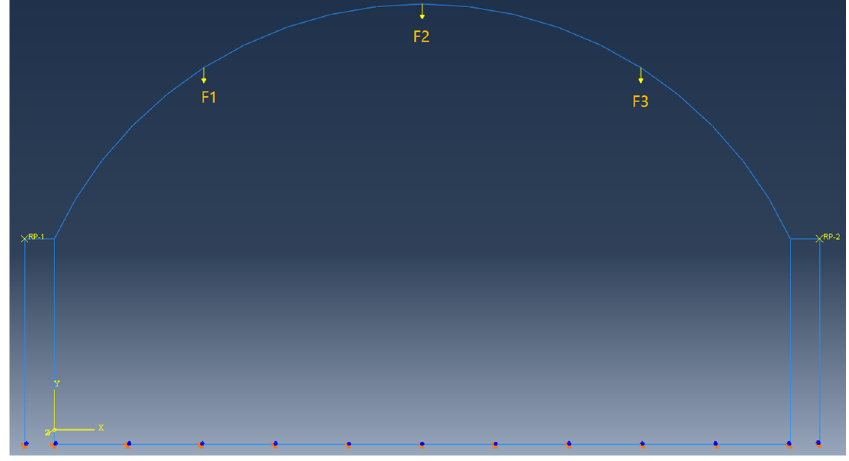
Figure 8. Strain measuring point. F1 is 40 kN; F2 is 50 kN; F3 is 100 kN; RP-1 and RP-2 are the reference points for the contact between the stiff pole and the canal structure.